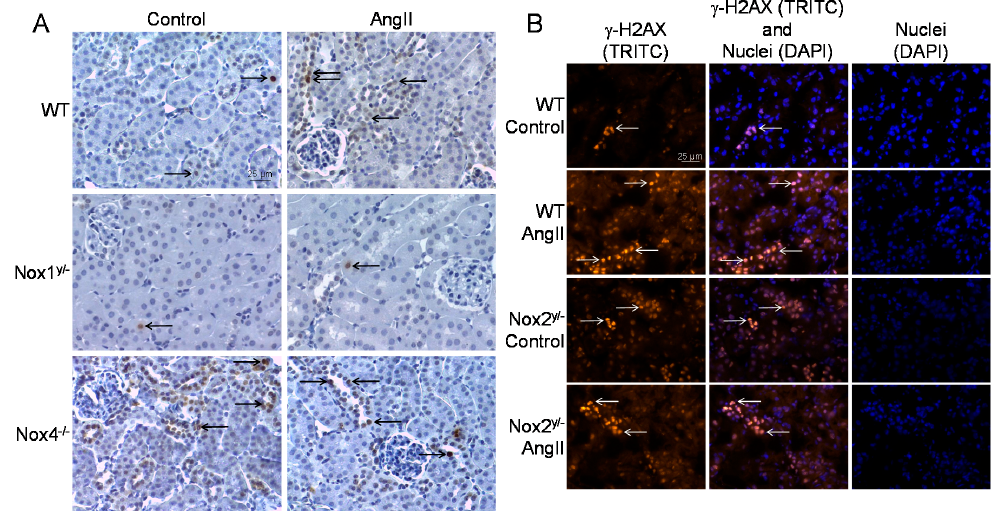
Figure 6. DNA damage in the kidneys of wildtype and Nox knockout animals. ( A ) Representative pictures of the immunohistochemical staining of para ffi n-embedded kidney sections of animals of